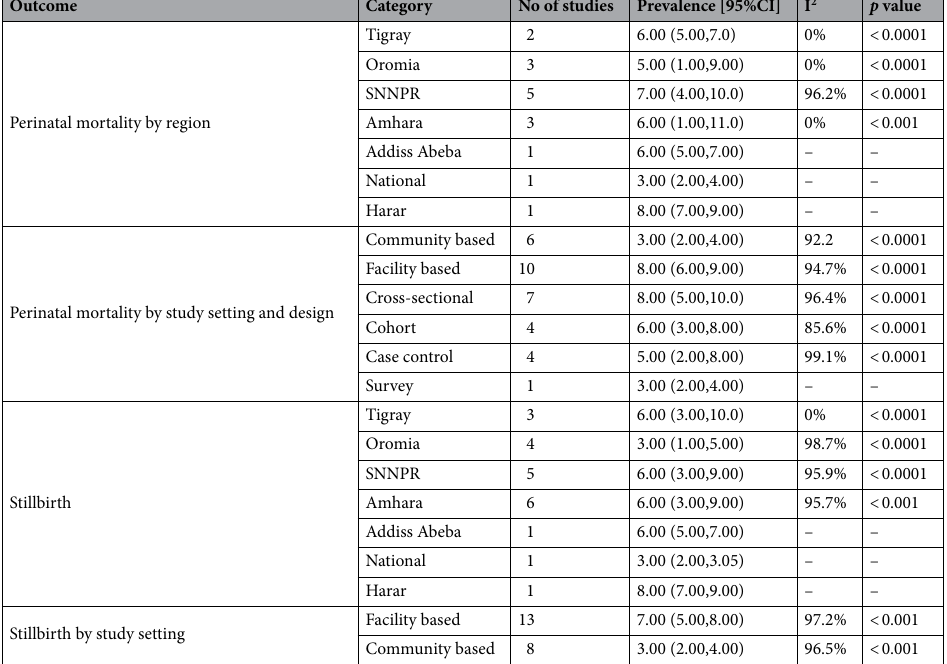
Table 2. Subgroup analysis of perinatal mortality and stillbirth by geographic region in